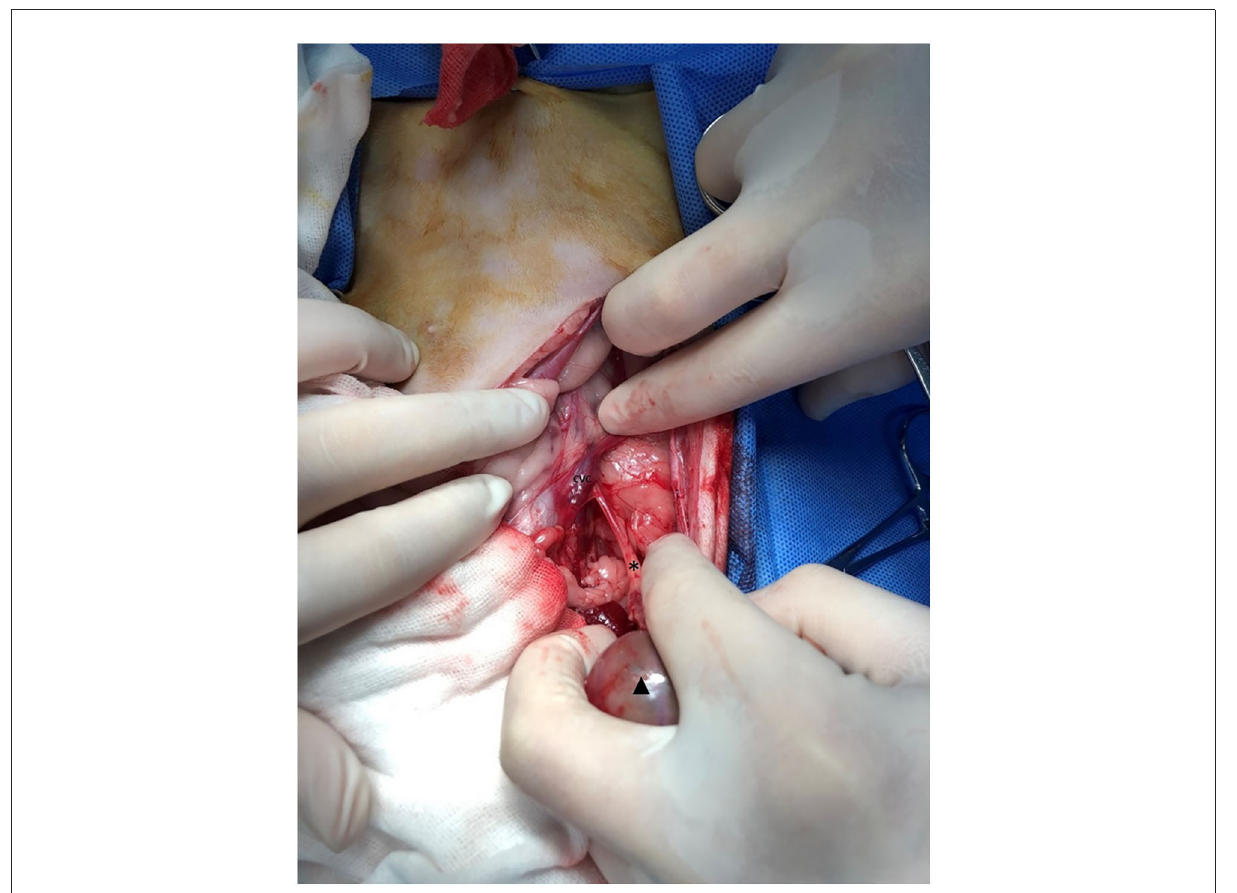
FIGURE4 Intra-operative image of the right kidney (triangle) and hydroureter (asterisk). The ureter rans dorsally to the caudal vena cava (CVC).